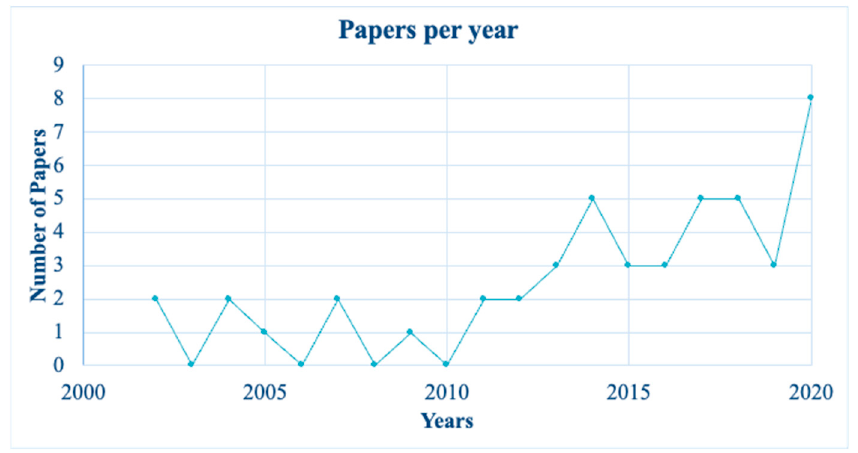
Figure 2. Publishing trend of the sample.